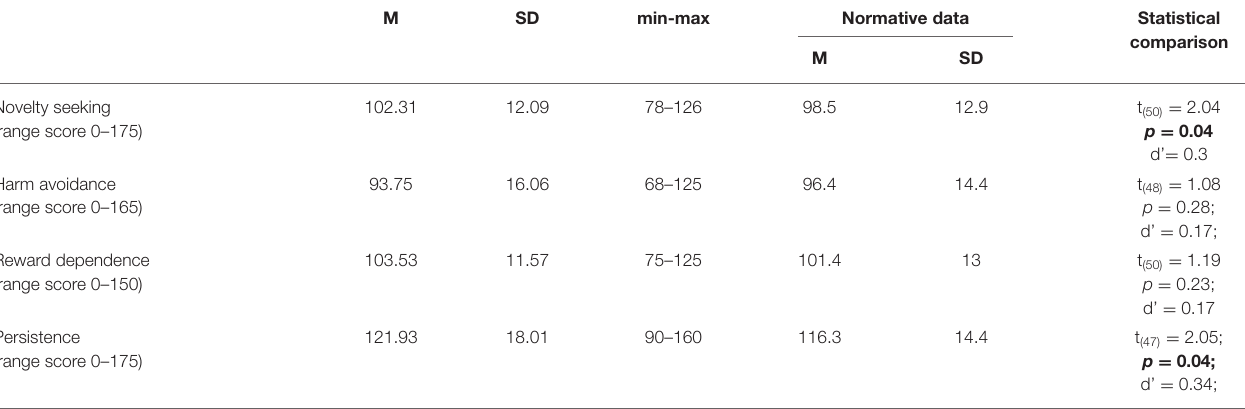
TABLE 3 | Mean, SD, and minimum (min) and maximum (max) for each scale of the Temperament and Character Inventory-Revised by Martinotti et al. (2008). M SD min-max Normative